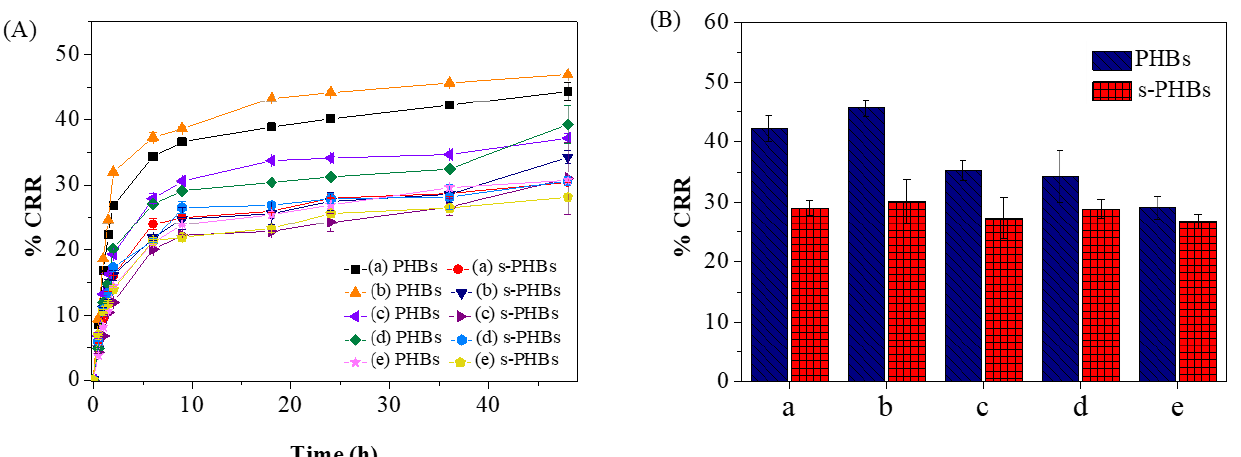
Figure 10. ( A ) Cumulative release ratio of PHBs and s-PHBs and ( B ) their plots for phosphate release in the last 24 h in rice field water samples located in different provinces; ( a ) Khon Kaen, ( b ) Nakhon Ratchasima, ( c ) Buriram, ( d ) Maha Sara Kham, and ( e ) Surin.